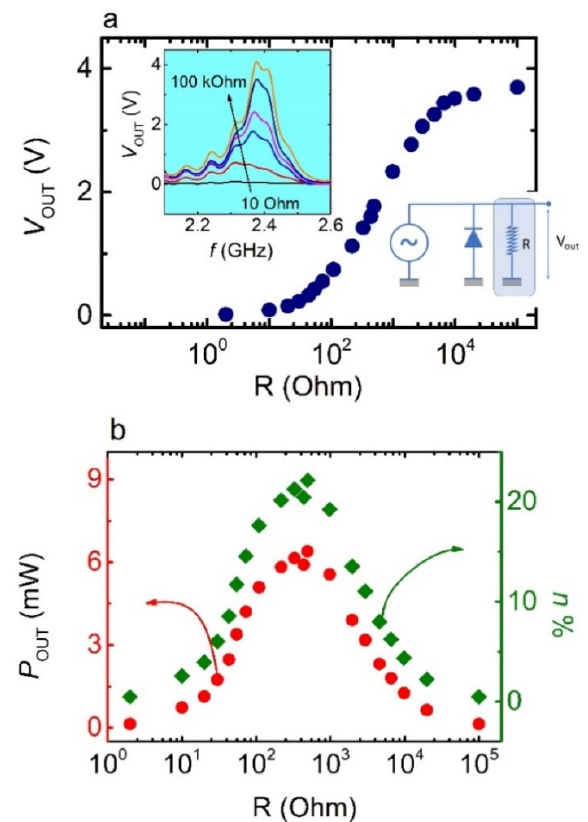
Figure 5. ( a ) Output voltage vs. resistance load. The equivalent electronic circuit is pictured in the right sketch. The AC power supply stands for the MS unit, which receives the microwave energy. The connected resistance is highlighted. Blue inset. V OUT vs. f for selected resistance loads. All of the curves exhibit maximum value at resonance frequency (2.32 GHz). The equivalent electronic circuit is pictured in the inset; ( b ) output power as a function of resistnace load (red solid circles) and efficiency vs. resistance (green solid rhombs). A clear maximum is obtained for ~500 Ohm.